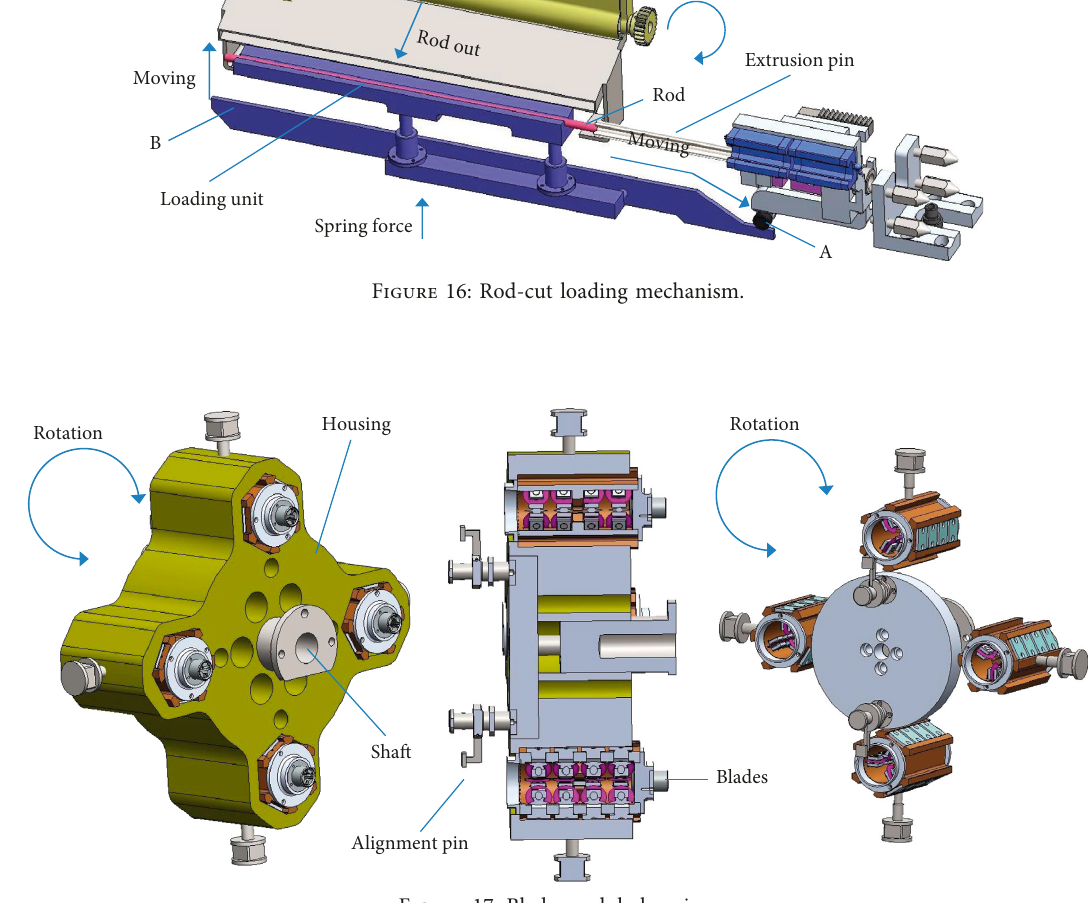
Figure 17: Blade module housing.